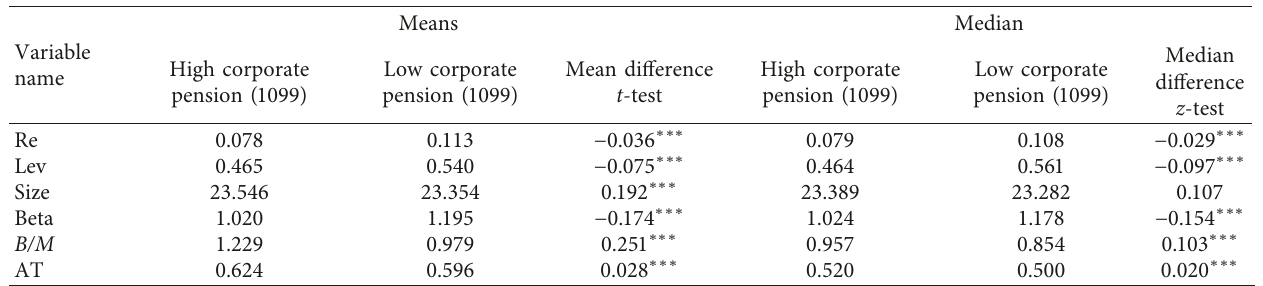
Table 4: Univariate empirical test.